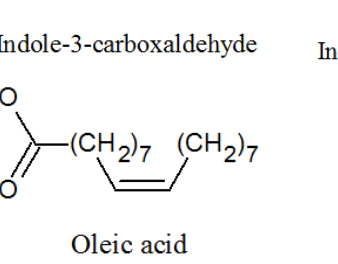
Figure 10. The structures of paecilaminols and others.